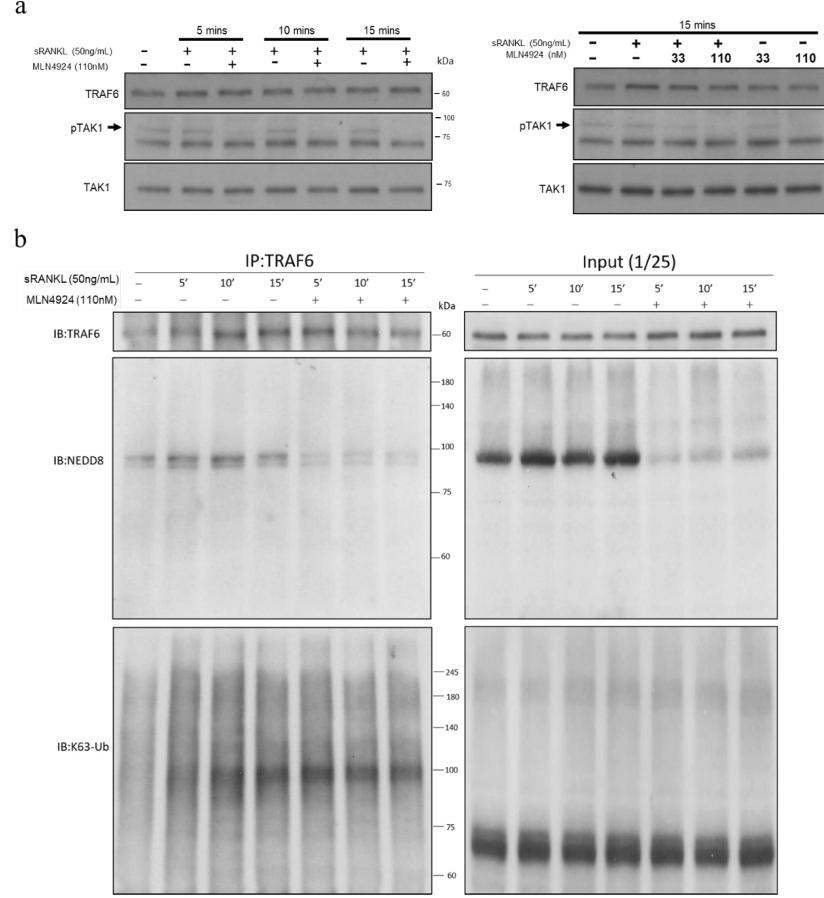
Figure 5. MLN4924 inhibits the soluble receptor activator of nuclear factor- κ B ligand (sRANKL)- induced phosphorylation of TAK1 to reduce the K63-Ub level of TRAF6. ( a ) RAW 264.7 cells